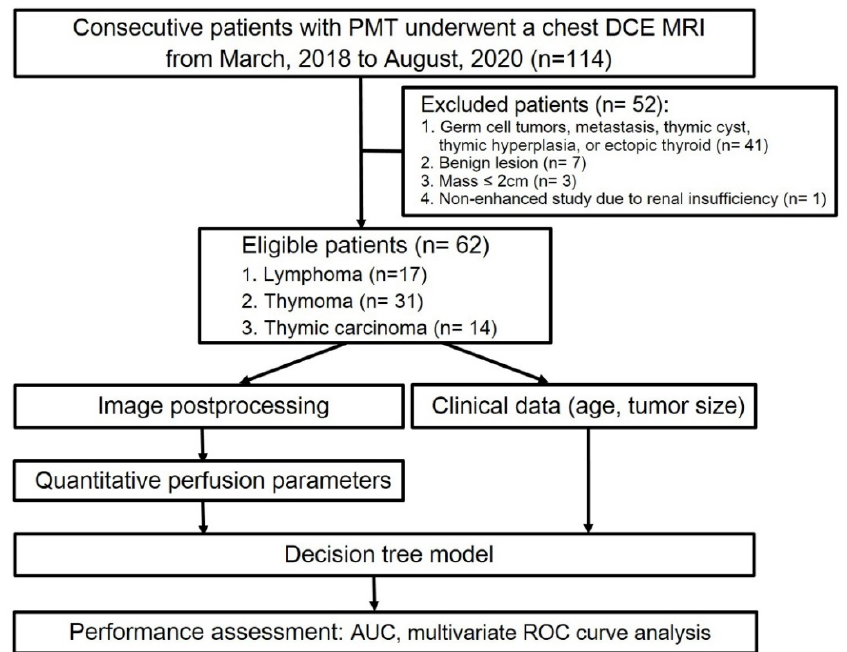
Figure 1. Flow diagram of patient selection and experimental procedure. Abbreviations: PMT = prevascular mediastinal tumor; TET = thymic epithelial tumor.